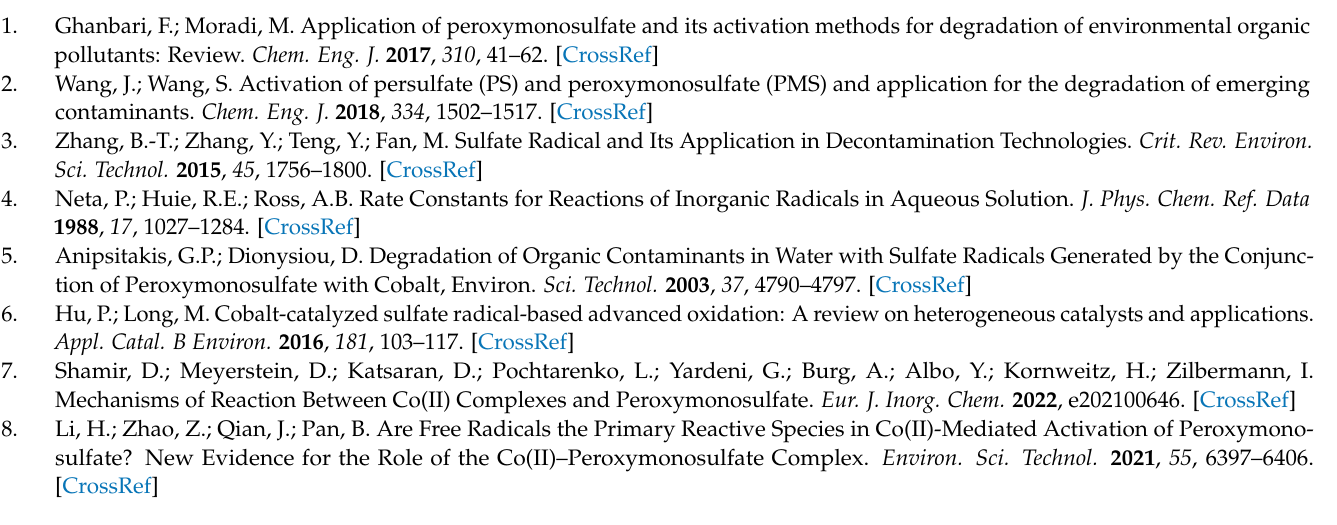
Figure S12. Time-course curves for the destruction of Orange II (5.5 · 10 − 5 M) by the mixture of H2OCbl (1.0 · 10 − 6 M) with HSO 5 − (5.0 · 10 − 4 M) at pH 7.4, 25.0 ◦ C in the presence of different phos- phate buffer concentrations; Figure S13. UV-vis spectra for the destruction of Orange II (5.7 · 10 − 5 M) by the mixture of H2OCbl (1.0 · 10 − 6 M) with HSO 5 − (5.0 · 10 − 4 M) at pH 7.4, 25.0 ◦ C in the presence